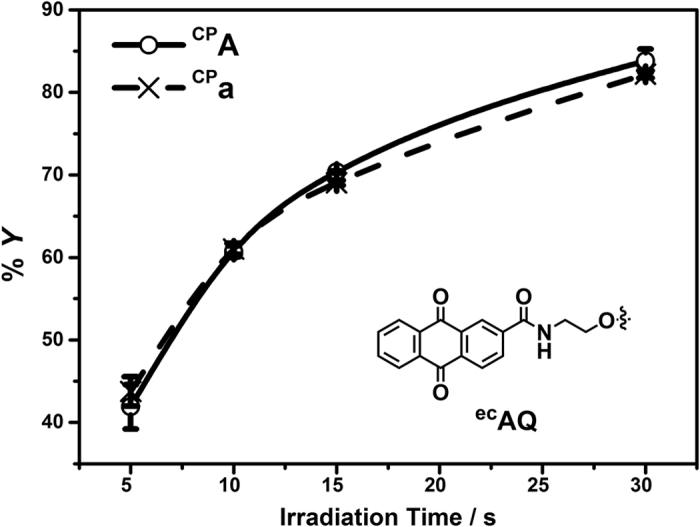
Percentage decomposition of CPA of 5′-ecAQCPAT-3′ (○) or CPa of 5′-ecAQCPau-3′ (×) as a function of irradiation time.(insert) Structure of ecAQ as photooxidant in dinucleotides.